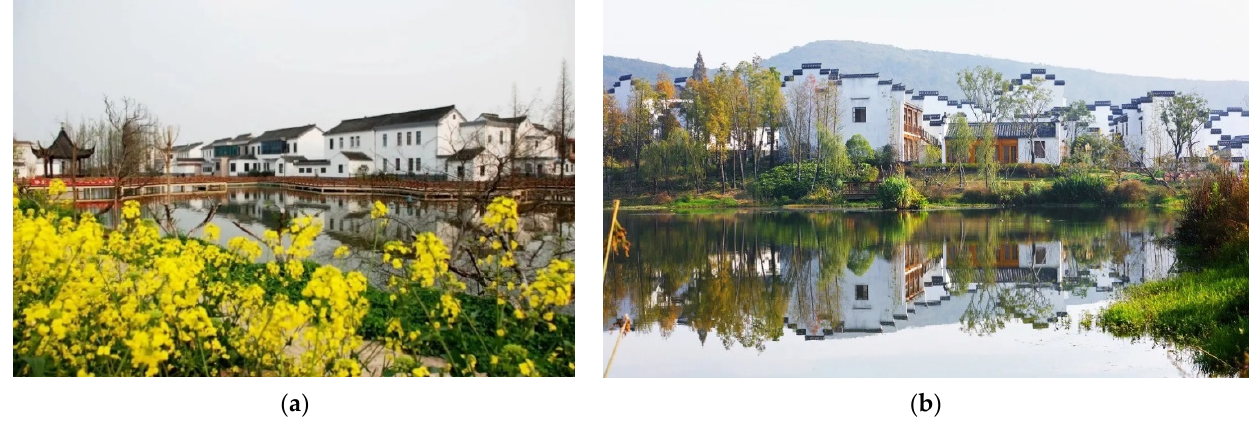
Figure 2. Rural tourism in the study sites. ( a ) B&B in Shanlian Village. ( b ) Agricultural attractions in Huashu Village. Table 1. A comparison between Shanlian Village and Huashu Village.